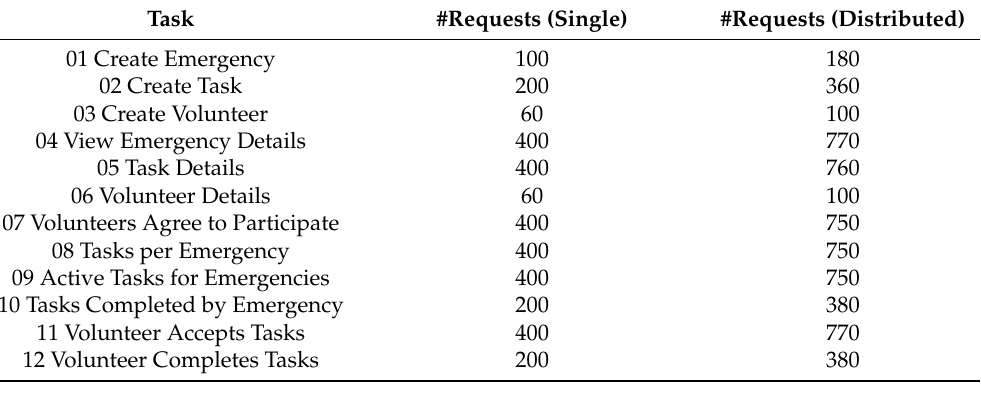
Table 1. Maximum number of requests supported by each task of the Ayni application on a single processor and with a distributed configuration.